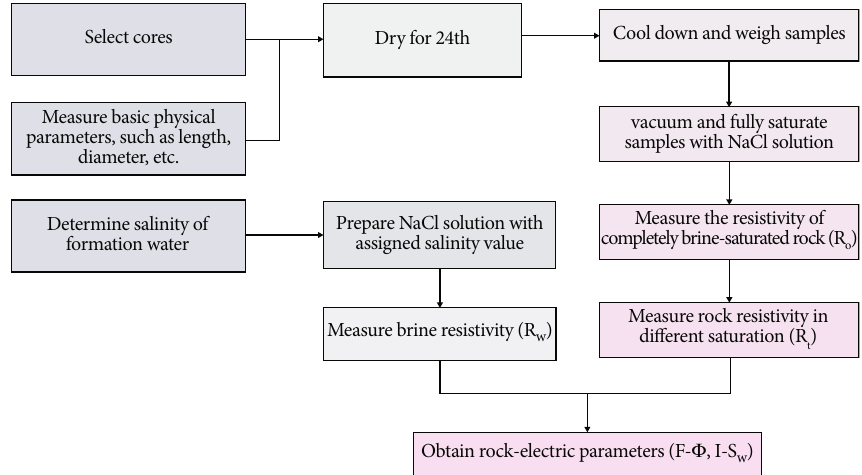
Figure 3: Work fl ow of rock-electric experiment in shale samples of LZ region.